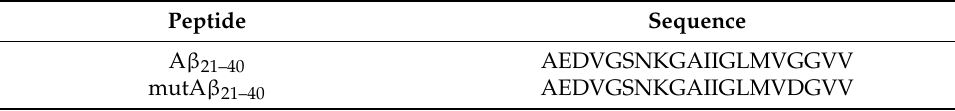
Table 1. Peptide sequences analyzed in this